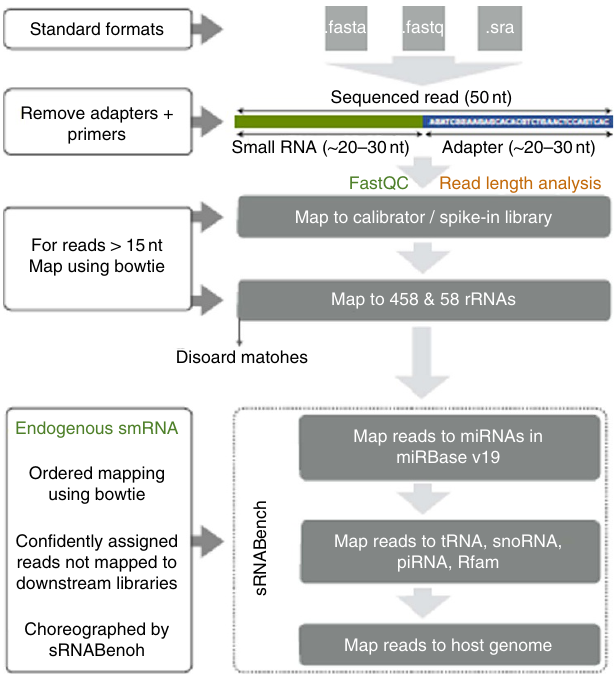
Figure 1 | Sequencing data analysis using the Genboree-sequencing pipeline. Small-RNAseq reads were processed and quantified using the exceRpt tool available on the Genboree Workbench. ExceRpt